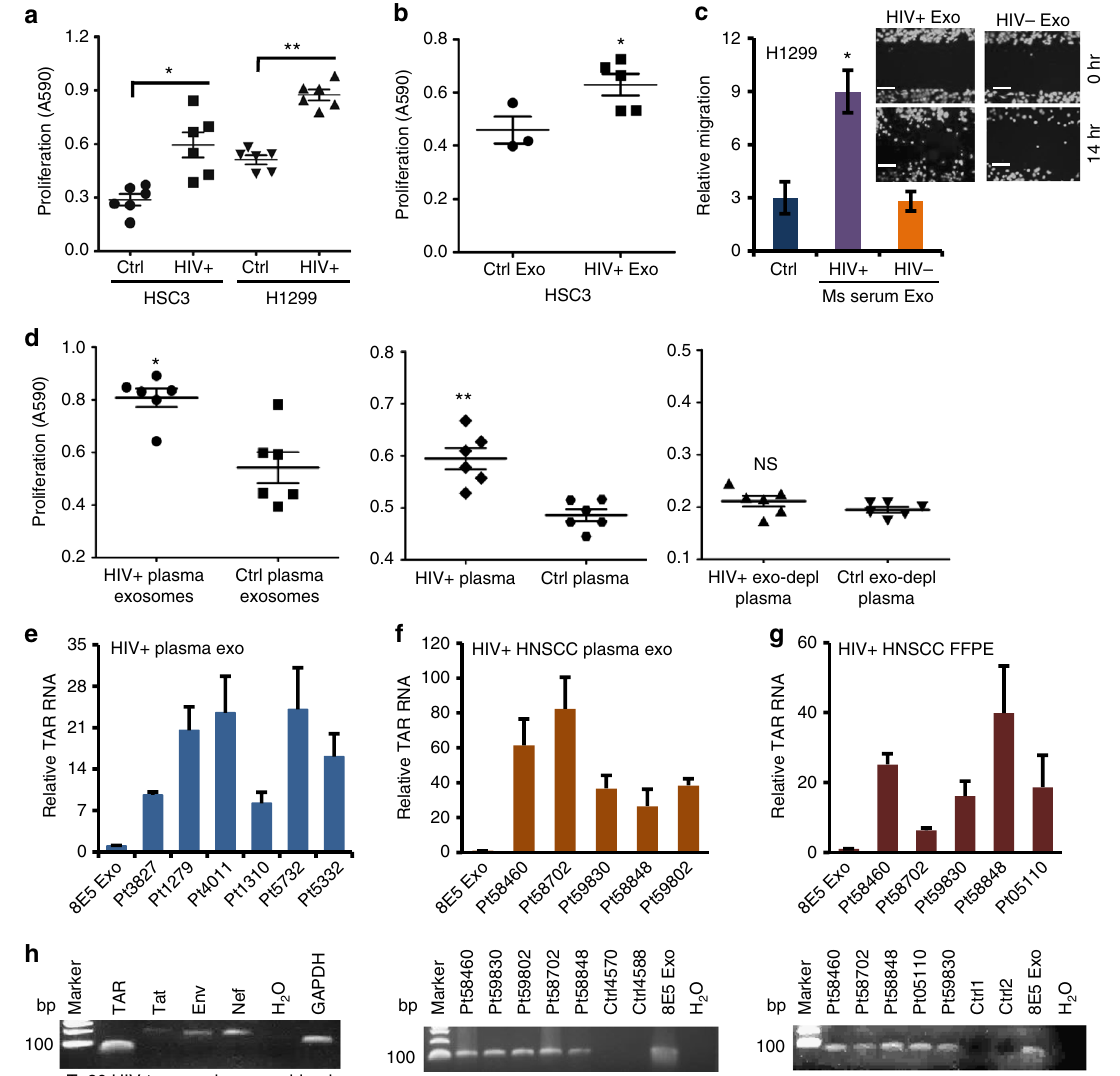
Fig. 4 Plasma exosomes from HIV-infected patients promote cancer cell growth. a Proliferation of HSC3 and H1299 cells treated with exosomes (3.9 – 4.5 × 10 9 ml − 1 ) from the plasma of normal (Ctrl) and HIV-infected subjects (HIV + ) for 5 days. Error bars, ± s.d., n = 6; * p < 0.002 and ** p < 0.0001, Student ’ s t - test. b Proliferation of HSC3 cells treated with exosomes (4.1 – 4.8 × 10 9 ml − 1 ) from plasma of normal (Ctrl, n = 3) and HIV-positive HNSCC subjects (HIV + Exo, n = 5) for 5 days. Error bars, ± s.d., * p < 0.04, one-way ANOVA. c Migration of H1299 lung cancer cells treated with exosomes from sera of Tg26 mice (HIV + ) or FVB control littermates (HIV − ) (4.2 × 10 9 ml − 1 ). Ms, mouse; Exo, exosomes. Error bars, ± s.d., n = 3, * p < 0.05, F -test. Data of one experiment from two repeats are shown. Inset, migration images; scale bars, 100 µ m. d Proliferation of HSC3 cells treated with the unmodi fi ed plasma (4.7 × 10 9 exosomes ml − 1 , left), puri fi ed plasma exosomes (4.7 × 10 9 ml − 1 , middle), and exosome-depleted plasma (right, exo-depl) from HIV-positive (HIV + ) or healthy people (Ctrl) on day 5. Error bars, ± s.d., n = 6; * p and ** p < 0.05, Student ’ s t -test. NS, p > 0.05. e qRT-PCR of TAR RNA on total RNA of plasma exosomes from HIV-positive subjects (HIV + plasma exo). Relative TAR RNA levels were compared to TAR RNA of 8E5/LV cell exosomes. Error bars, ± s.d. n = 3. 8E5 Exo, 8E5/LV cell exosomes. f qRT-PCR of TAR RNA of plasma exosomes from HIV-positive HNSCC patients (top). Relative TAR RNA expression is determined as in e . Errors bars, ± s.d., n = 3. Bottom, TAR RNA gel image; Ctrl4570 and Ctrl4588, exosomes from HIV-negative HNSCC patient plasma. g qRT-PCR of TAR RNA using total RNA extracted from FFPE sections of HIV-positive HNSCC patients (top). Relative TAR RNA levels were determined as in e . Error bars, ± s.d., n = 3. Bottom, TAR RNA gel image; Ctrl1 and Ctrl2, HIV-negative HNSCC FFPE sections. h RT-PCR of HIV RNA in whole blood RNA from Tg26 HIV-transgenic